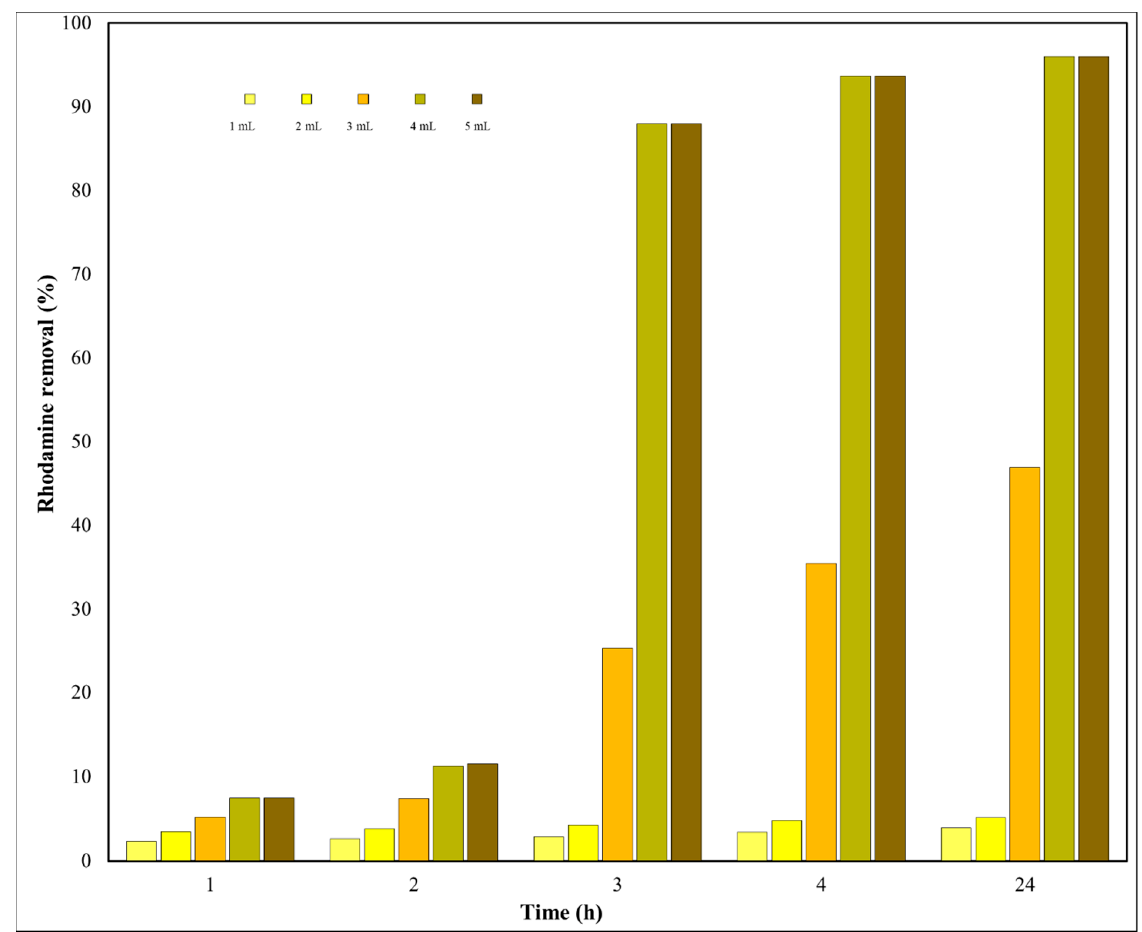
Figure 11. H 2 O 2 effect on the rhodamine removal (5 mg/L dye, 50 mg Ni-MCM-41 r as catalyst, 9.2 mL acetonitrile as sol- vent).